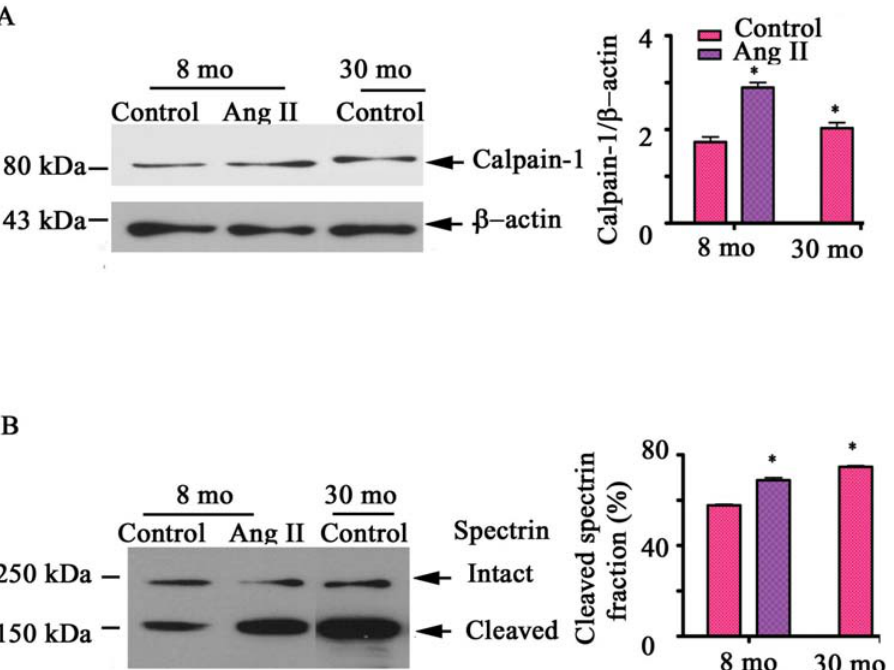
Figure 3. Calpain-1 induced ex vivo by Ang II. A. Western blots of calpain-1 and b -actin of arterial rings from young and old rats treated with Ang II for 72 hrs (left panels); average data (right panel). B. Western blots of the calpain substrate, a -II spectrin, of arterial rings from young and old rats treated with Ang II for 72 hrs (left panel); average data of cleaved a -II spectrin fraction (right panel). *p , 0.05, vs. young untreated rings (control).